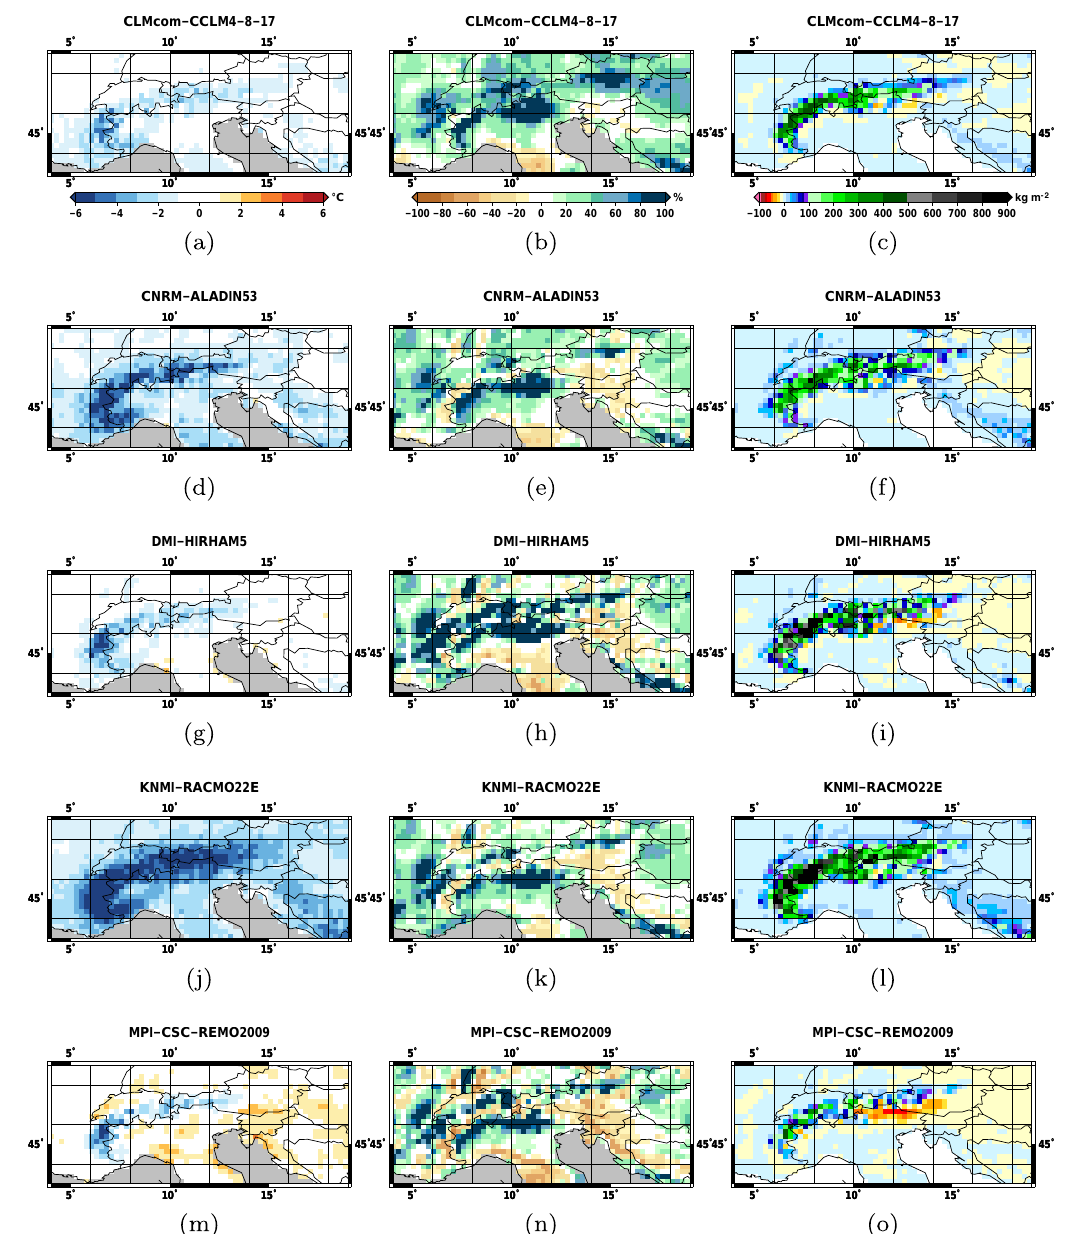
Figure 4. As in Fig. 3 but for the CORDEX ERA-Interim-driven RCM simulations, averaged over the period 1990–2005.